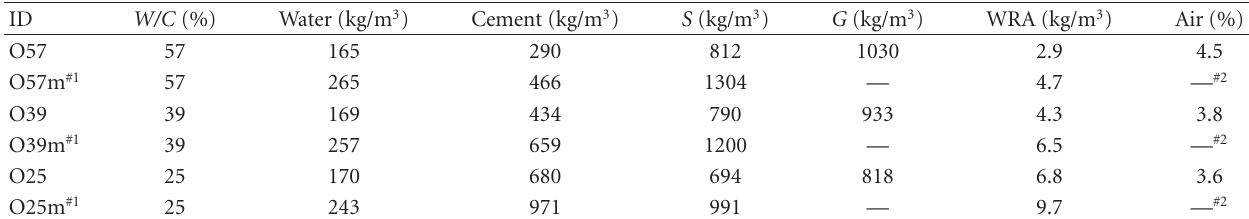
Table 3: Mixture proportions of concrete.